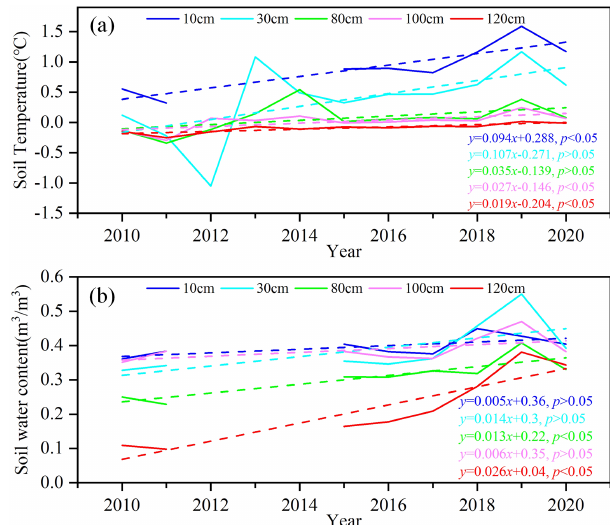
Figure 6. Soil temperature and soil volumetric water content at five depths from 2010 to 2020 at the Mahan Mountain permafrost site: soil temperature (a) ; soil volumetric water content (b) .